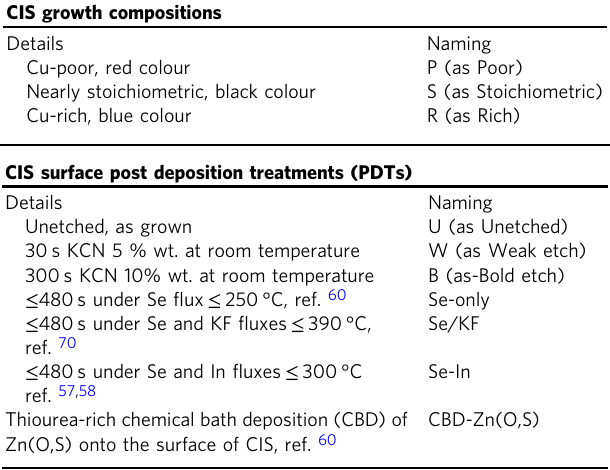
Table 1 Sample identi fi cation